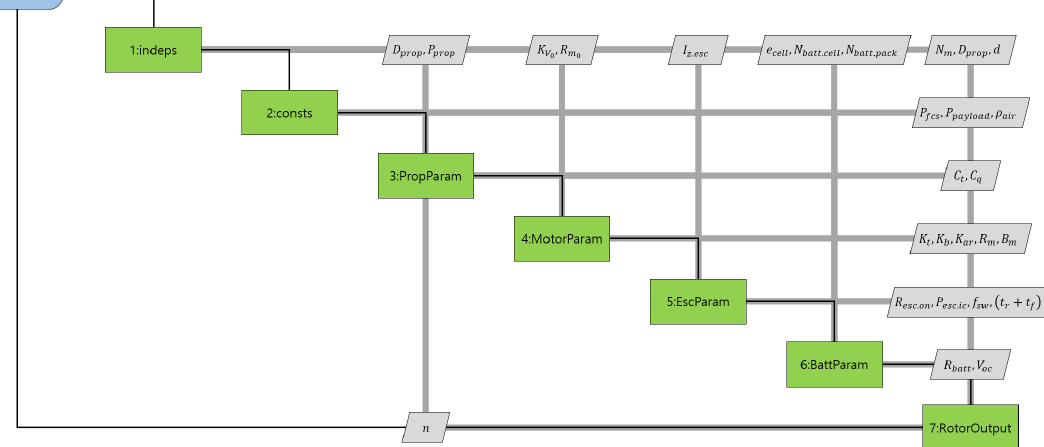
Figure 14. Extended design structure matrix for the performance calculation process of the proposed electric propulsion system